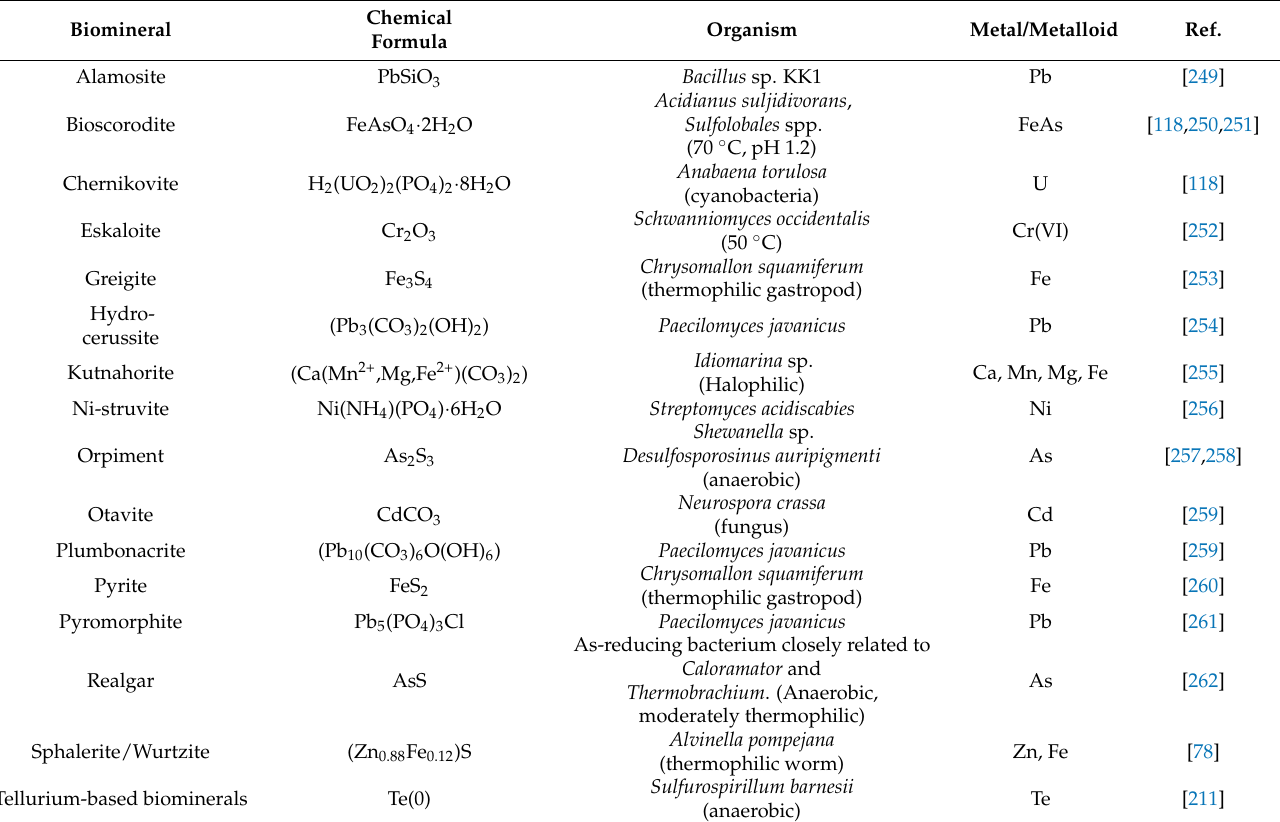
Table 2. Selected examples of biominerals produced by a variety of forced biomineralization pathways.